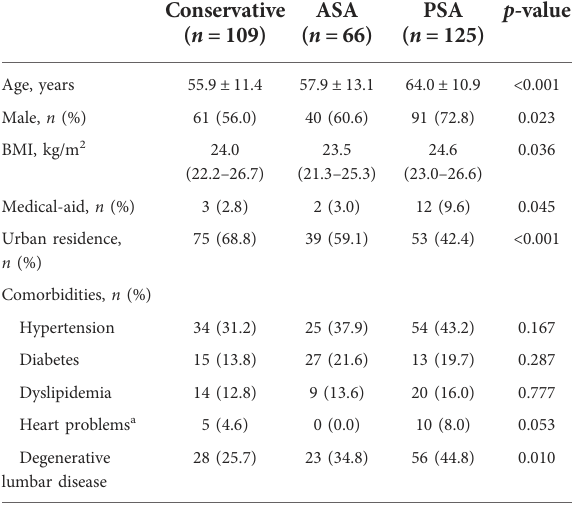
TABLE 2 Disease-related features. TABLE 1 Baseline